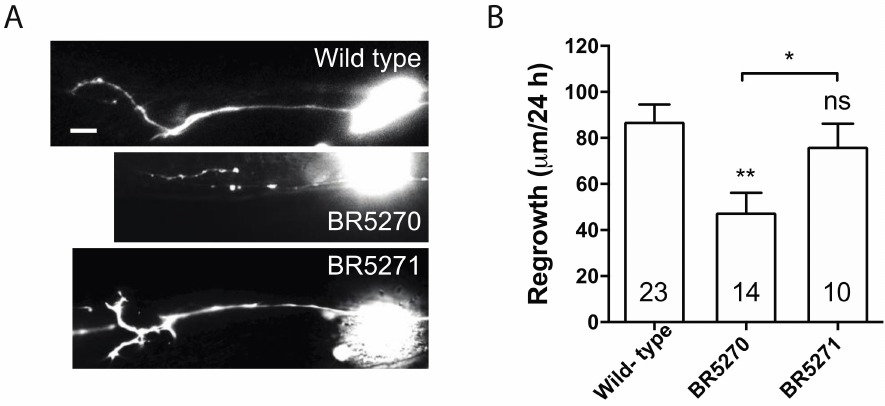
Figure 2. Pro-aggregant Tau impairs axon regeneration post injury. ( A ) Representative images of PLM axon regeneration 24 h post-laser axotomy in the wild-type animals, BR5270 strain expressing pro-aggregant Tau, and BR5271 strain expressing anti-aggregant Tau. PLM axon is visualized by touch neuron-specific GFP expression driven by a mec-7 promoter. Scale bar: 10 µ m. ( B ) Quantification of axon regeneration for experiments in ( A ). Statistics: one-way ANOVA; mean ± SEM; * p < 0.05; ** p < 0.01; ns, Not